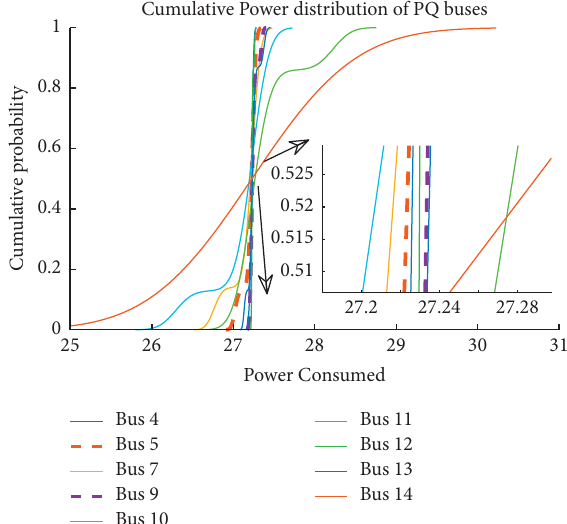
Cumulative Power distribution of PQ buses